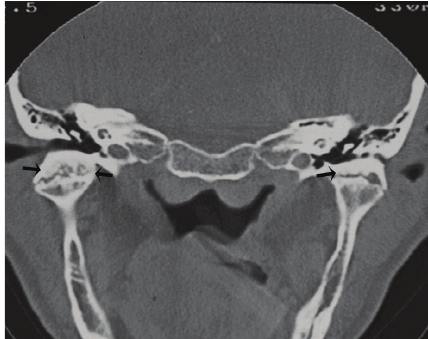
Figure 2: Coronal CT image demonstrating bilateral joint space narrowing, rough condylar surfaces, and sclerosis of the subchon- dral bone (arrows).